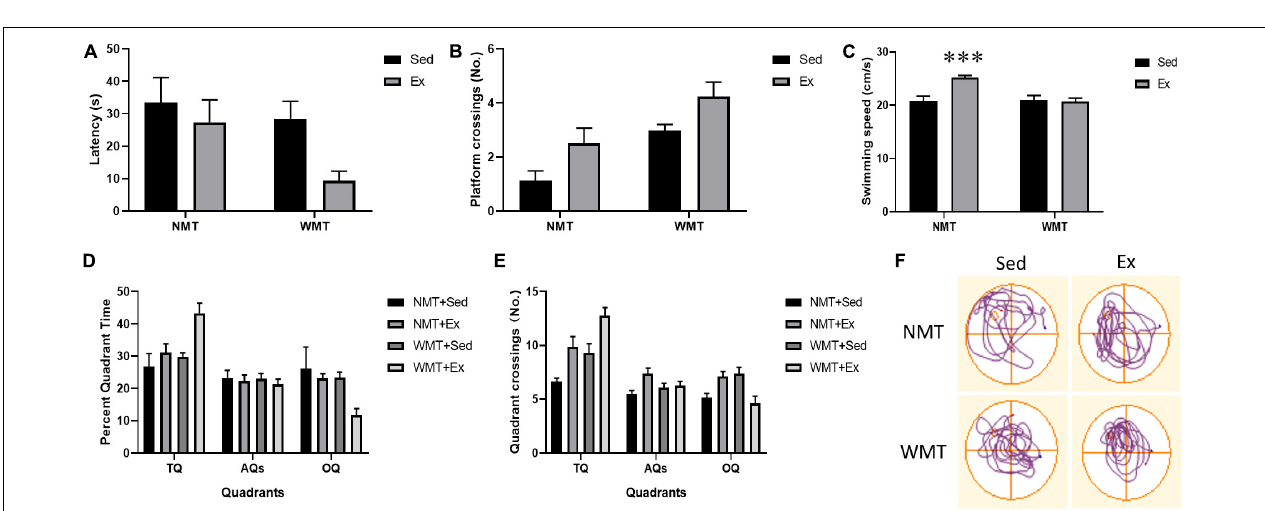
FIGURE 5 | Weakened memory traces induced by exercise facilitate consolidation of new memory. (A,B) Experience and exercise both facilitate decreasing target platform latency and enhance the number of crossings in the platform location during the final probe test. (C) Swimming speed during the final probe test. Exercise increased mice swimming speed in the NMT groups. (D,E) Experience and exercise increase the percent quadrant time and number of crossings in the target quadrant (TQ). Similarly, both experience and exercise decreased the percent quadrant time in the opposite quadrant (OQ). Exercise increases the number of OQ crossings in the NMT groups, whereas it decreases the number of OQ crossings in the WMT groups. Exercise also increases adjacent quadrants (AQs) crossings only in the NMT groups, with no effect on the percent quadrant time in AQs in both the NMT and WMT groups. (F) Trajectories of mice exploring the maze during the final probe test. Data are graphed as means ± SEM ( n = 8–13); Data analysis used two-way ANOVA. ∗∗∗ p <